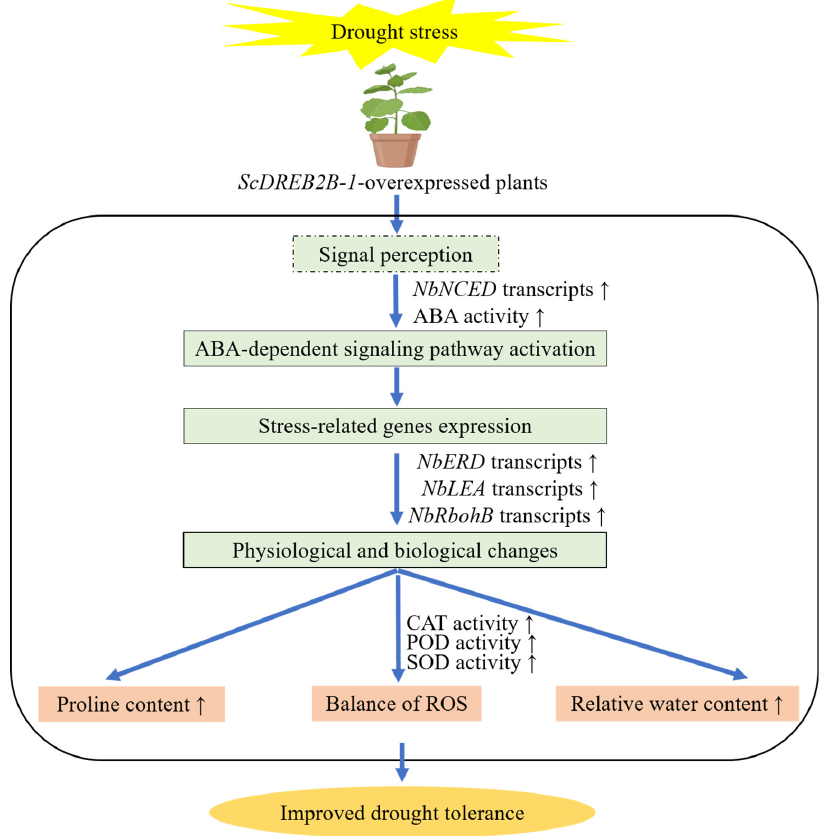
Figure 10. Proposed working model for the sugarcane ScDREB2B-1 overexpression-mediated regula- tion of Nicotiana benthamiana under drought stress. NbNCED : nine-cis-epoxycarotenoid dioxygenase gene; ABA: abscisic acid; NbERD : early responsive to dehydration gene; NbLEA : late-embryogenesis- abundant protein; NbRbohB : respiratory burst oxidase homolog protein B; CAT: catalase; POD: peroxidase; SOD: superoxide dismutase; ROS: reactive oxygen species. The up arrow indicated that the detected physiological and biochemical indexes and gene expression level in the transgenic plants were higher than that in the wild-type plants under drought stress.